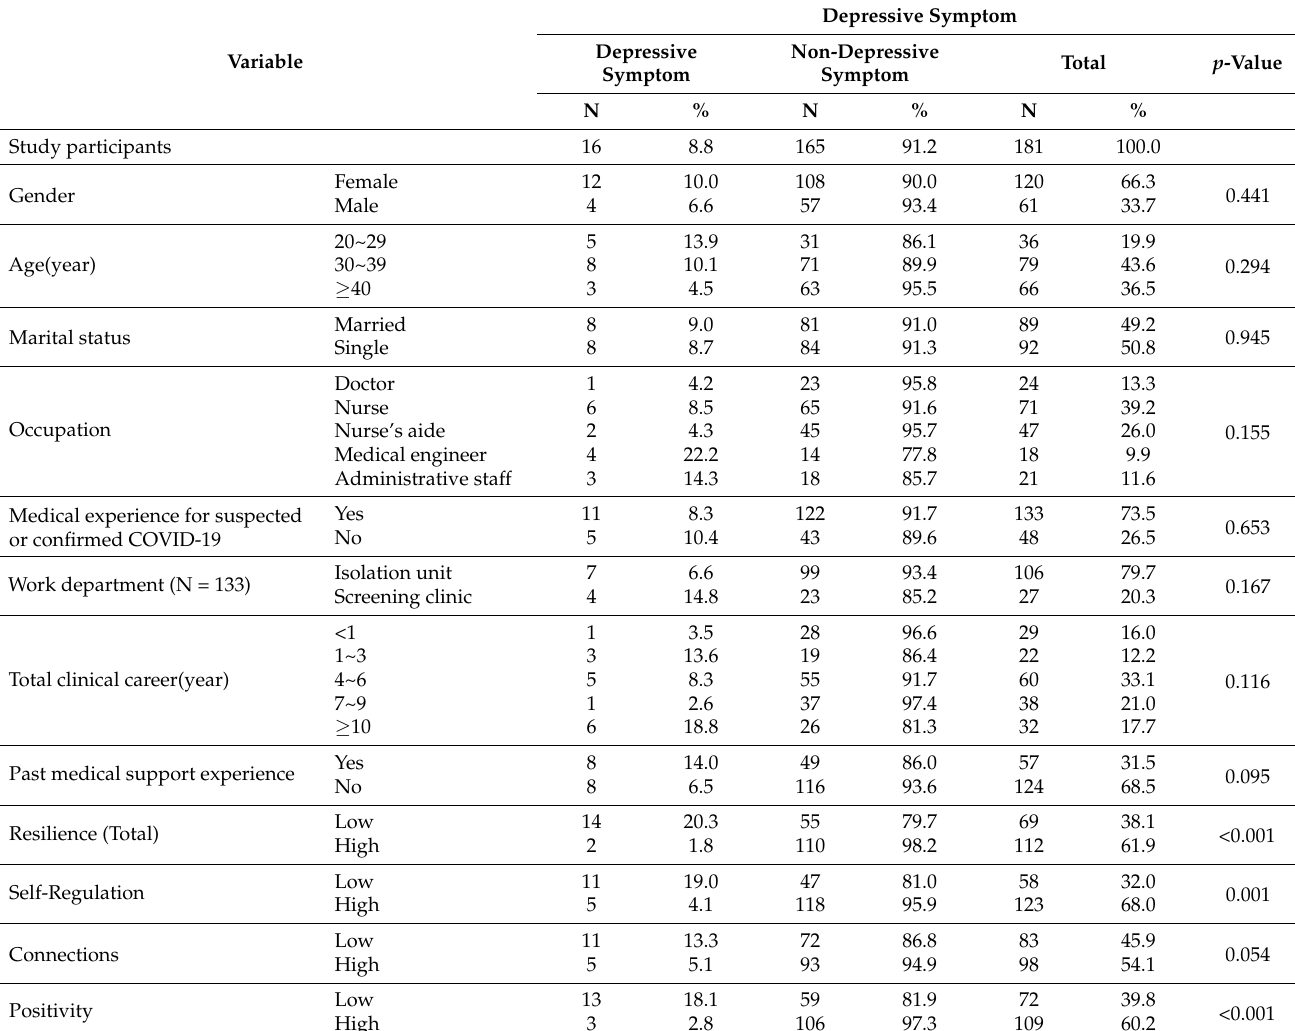
Table 1. Demographic and occupational characteristics and Resilience according to depressive